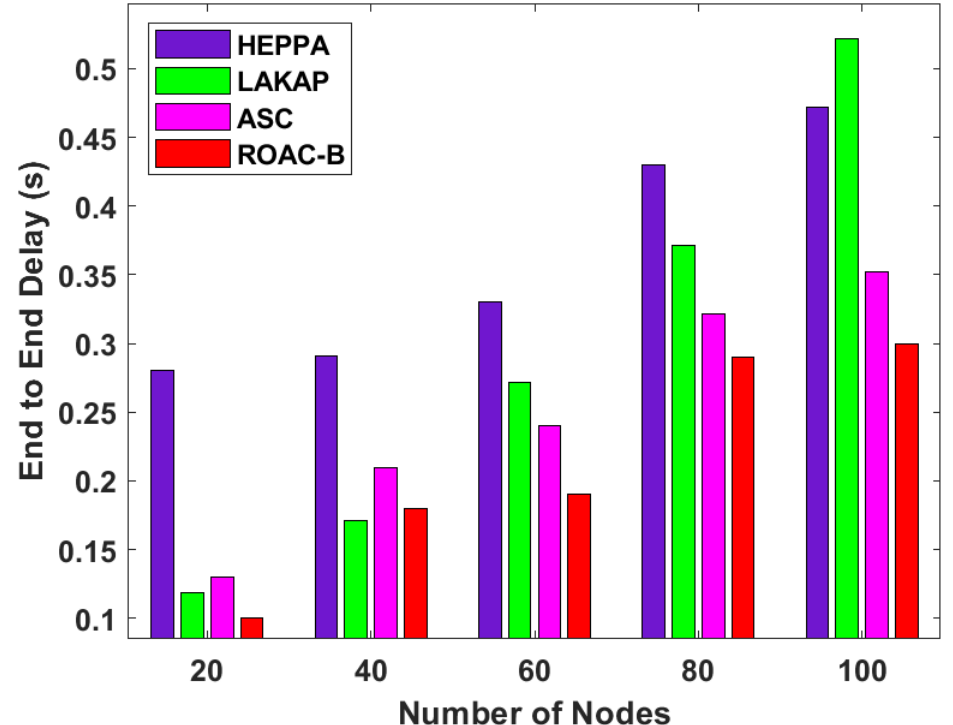
Figure 7. End to end (ETE) delay analysis of the ROAC-B technique. HEPPA: hybrid method for